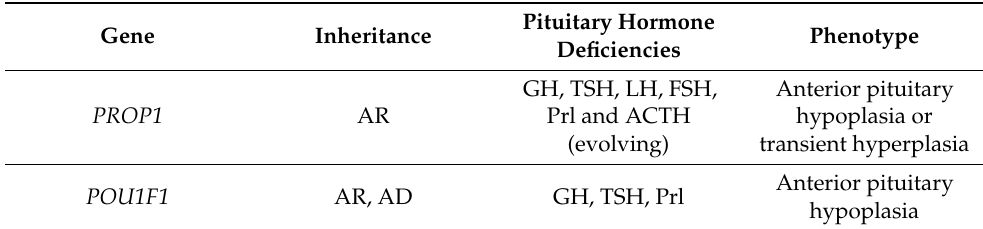
Table 1. Genetic disorders in non-syndromic combined pituitary hormone deficiency [28,59].